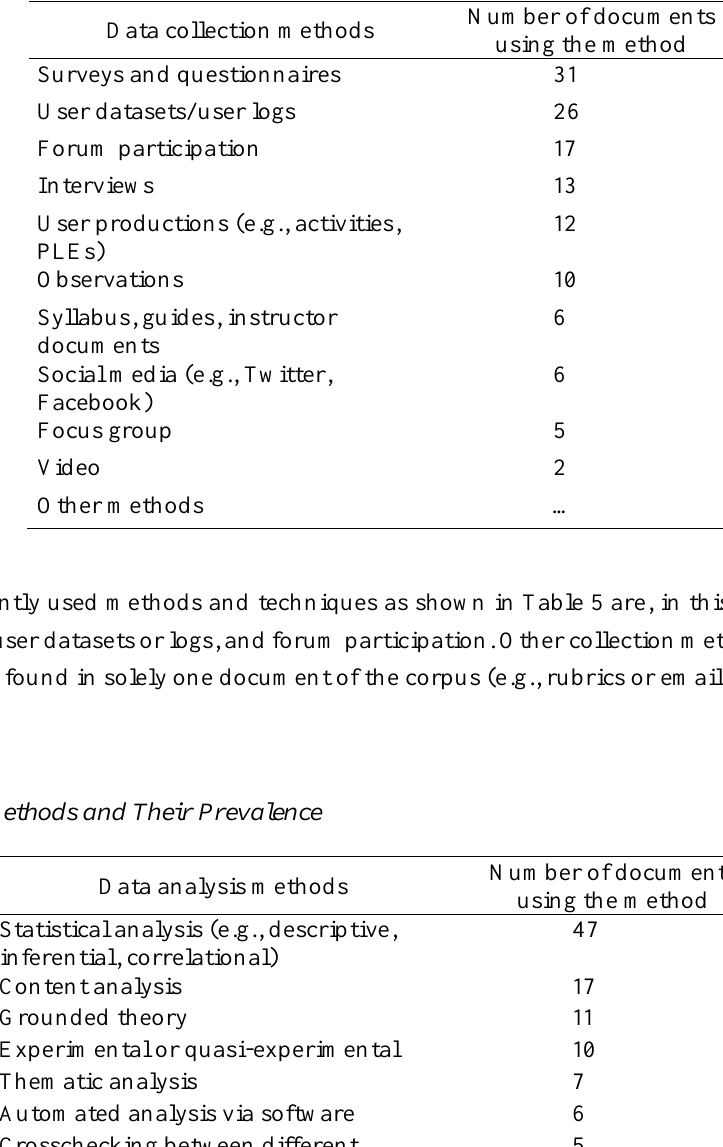
Table 5 Data Collection Methods and Their Prevalence